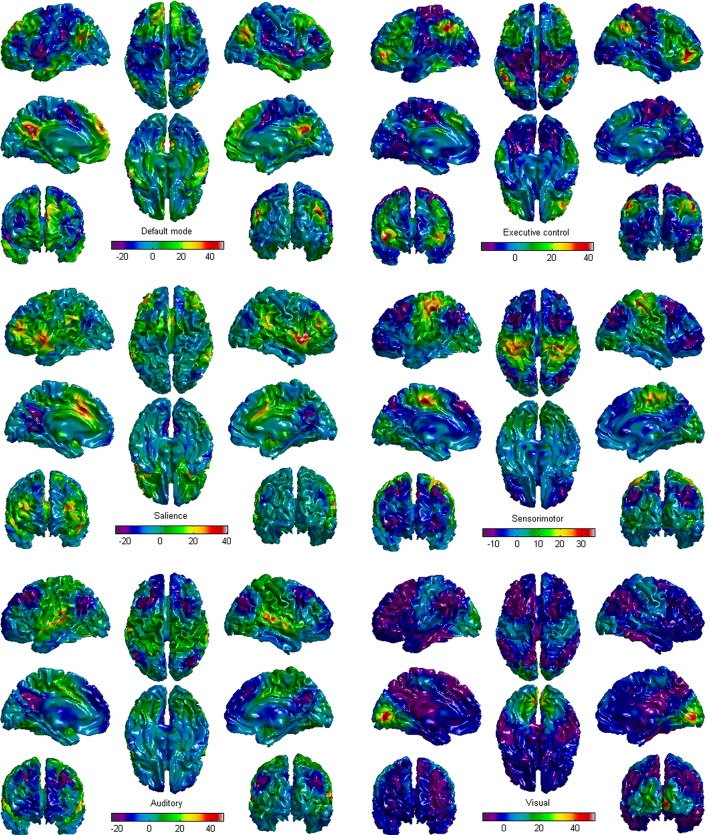
The six brain functional network templates in this study.